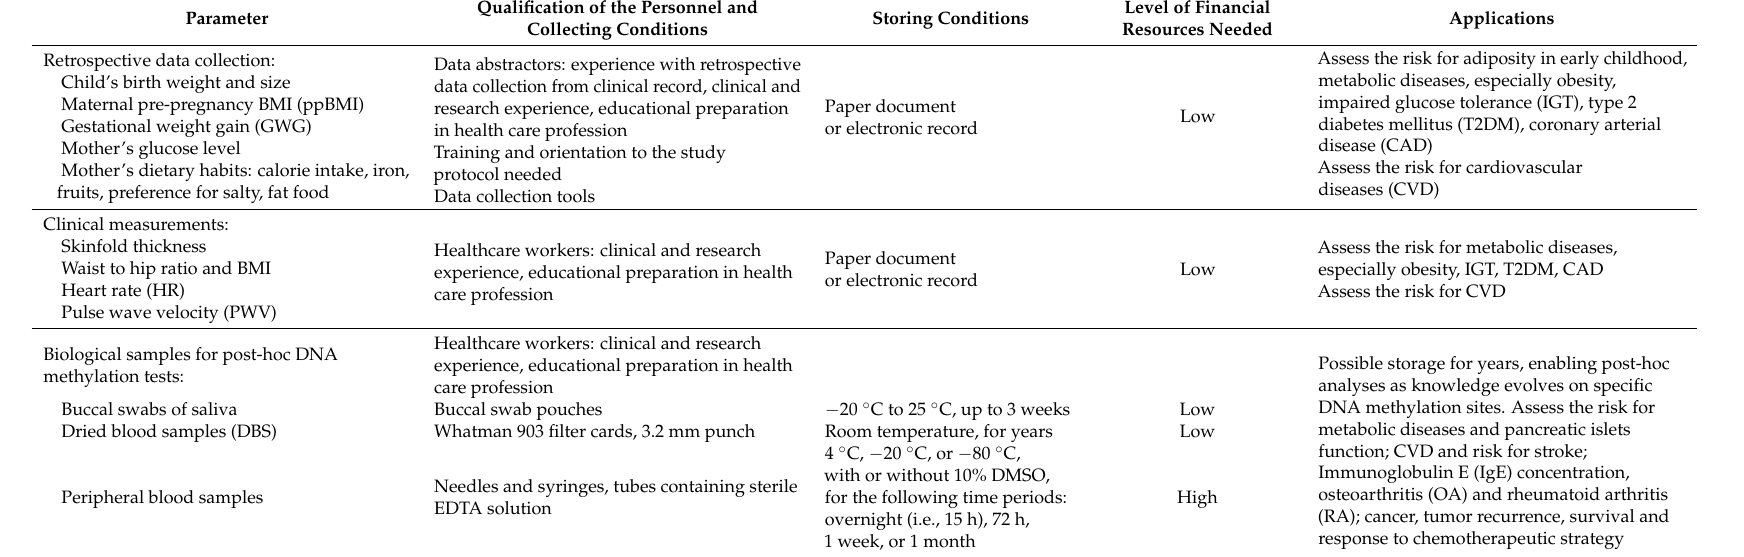
Table 3. Parameters to assess long-term effects of malnutrition (PALTEM) (in incremental order from low to high amount of financial resources